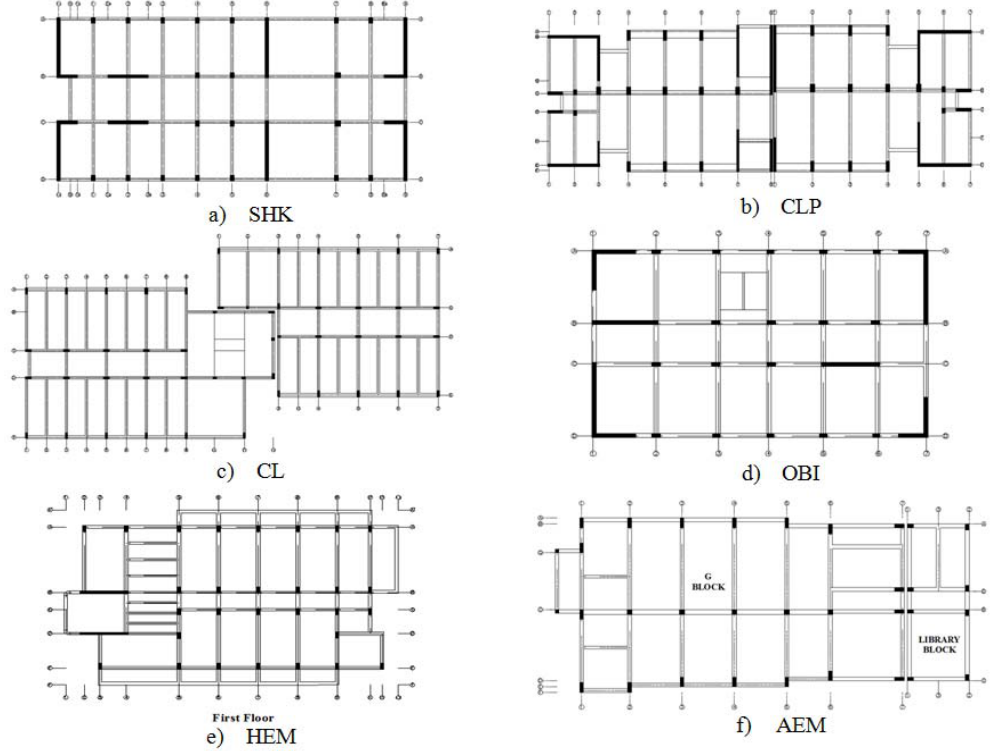
Fig. 4. Structural plan of the buildings.